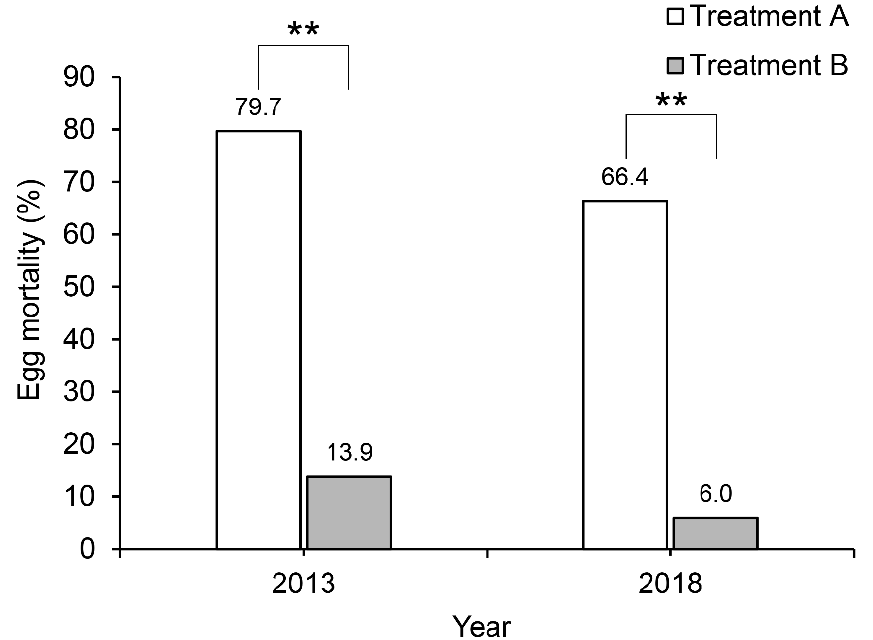
Figure 2. Mortality of eggs of R. foveipennis in pear fruits under treatments A and B in year 2013 and 2018. The mortalities in treatment A were significantly higher than those in treatment B in both years; ** statistical significance at 0.01 level.